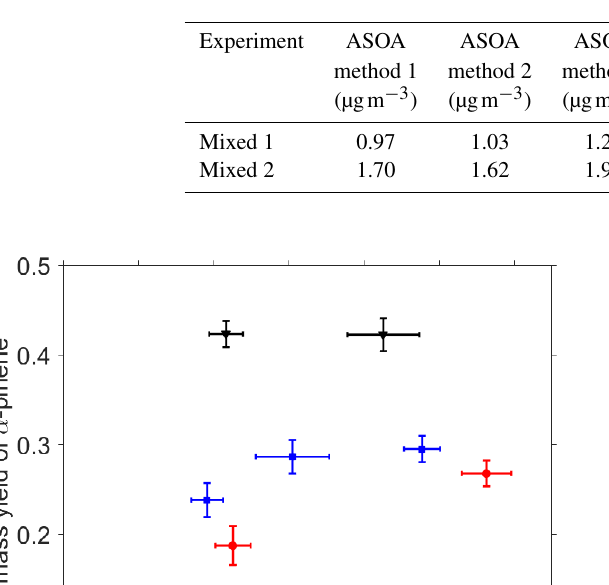
Table 4. Vehicle-derived SOA formed in Mixed experiments estimated with different approaches described in Sect. 3.3. RSD is relative standard deviation.